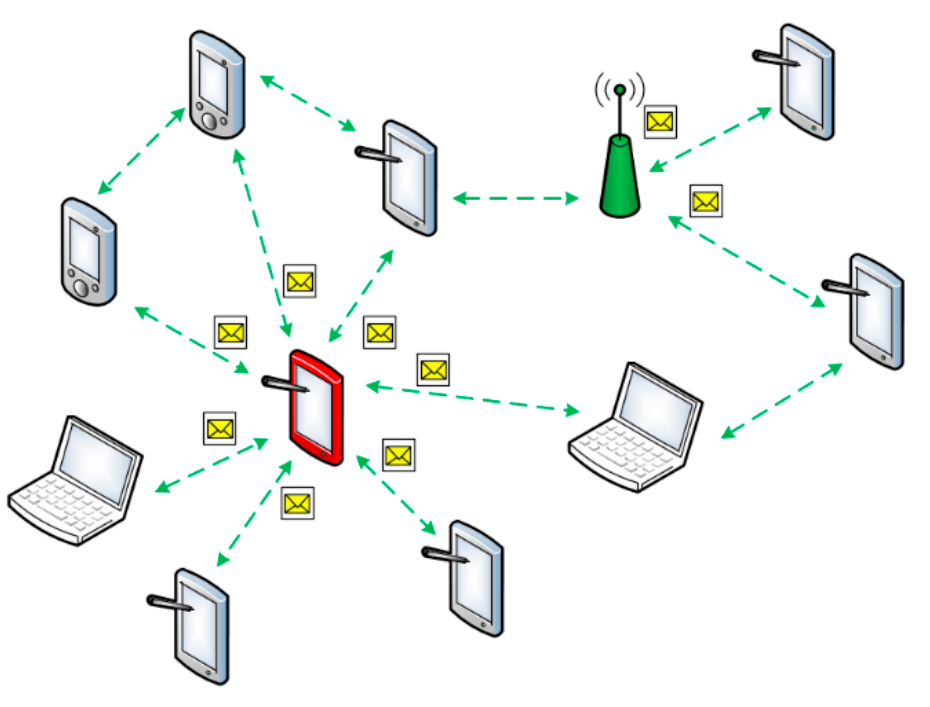
Figure 7. The sinkhole attack case.